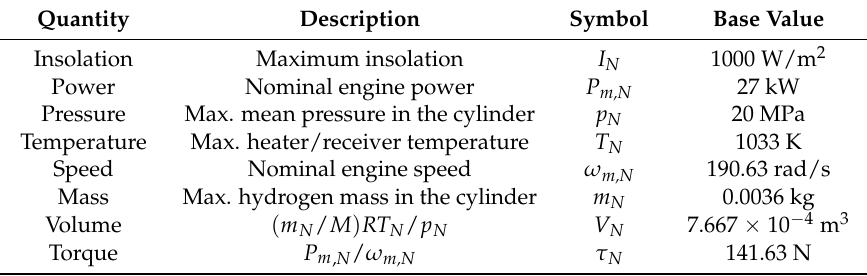
Table 1. Per unit system for the prime mover and hydrogen supply system